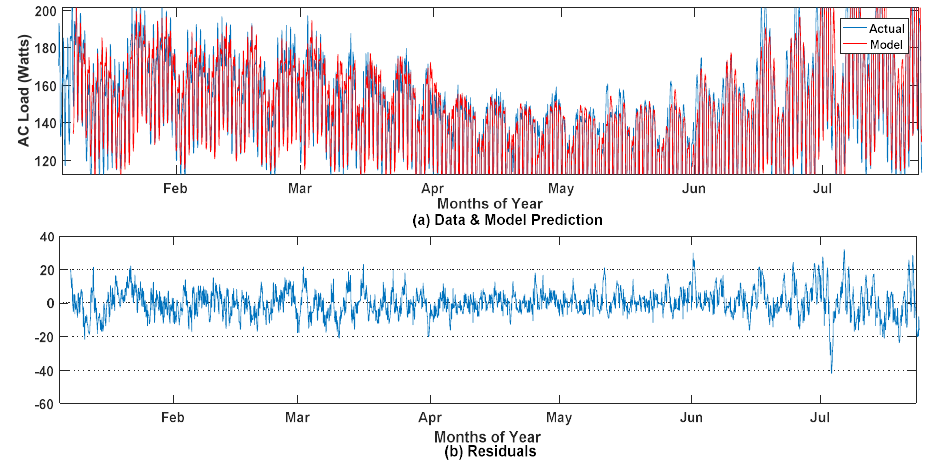
Figure 6. Actual and forecasted AC load by Scaled Conjugate Gradient (SCG)-based ANN approach .